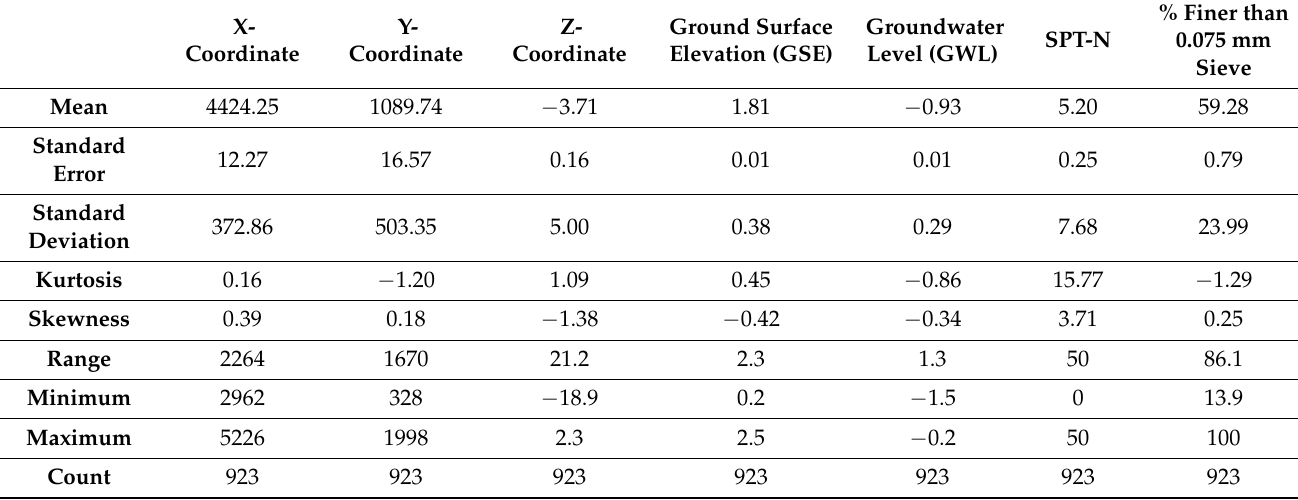
Figure 3. Frequency distribution histogram of machine learning attributes from the dataset. Table 1. The statistical information of each attribute in this study .